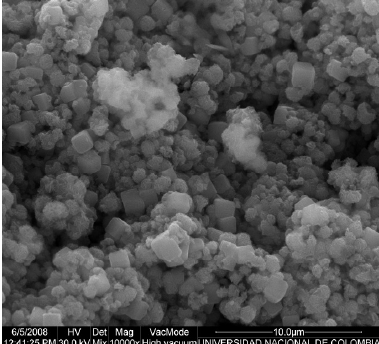
Figure 10 . Scanning electron microscopy of the sieve obtained (Zoom 10000X).